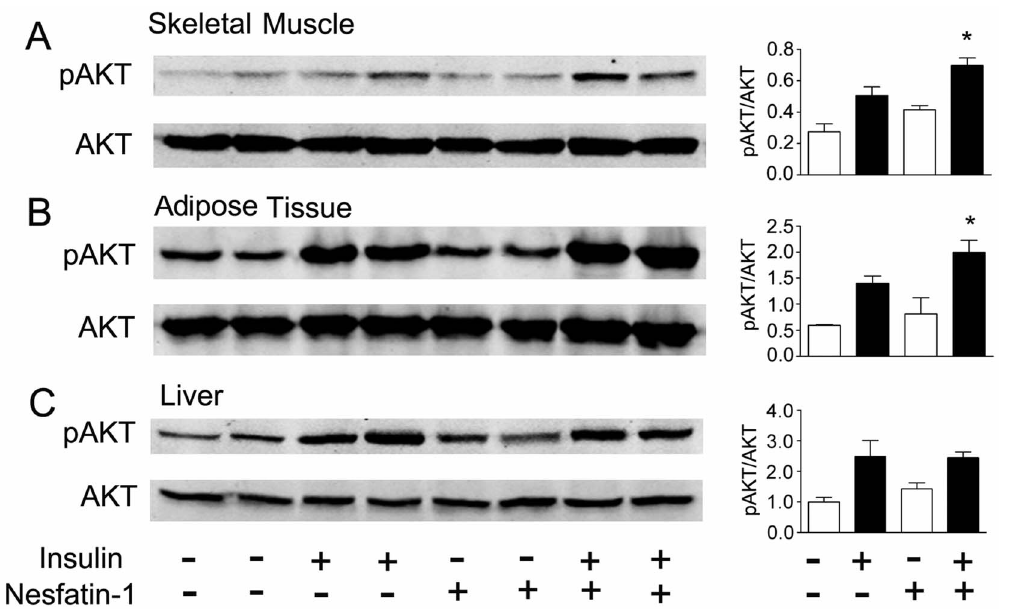
Figure 6. Effects of peripheral nesfatin-1 infusion on phosphorylation of AKT in mice fed high fat diet. Mice were fed high fat diet for 8 weeks, and then received subcutaneous infusion of saline (control) or nesfatin-1 for 2 weeks. Insulin at a dose of 2 IU/kg was injected intraperitoneally 10 min before animals were sacrificed. Phospho AKT (ser473) and AKT were detected by Western blotting using specific antibodies, in which AKT was used as internal controls. Shown are representative results from saline (control) and nesfatin-1 infusion mice with or without insulin injection. Levels of AKT phosphorylation were examined in skeletal muscle (A), adipose tissue (B) and liver (C) in mice fed high fat diet. Intensity of phosphor-AKT signals were quantified by NIH Image J software and expressed as mean 6 SEM. * P , 0.05 vs. insulin stimulation without nesfatin-1 treatment. Six samples were examined for each condition.